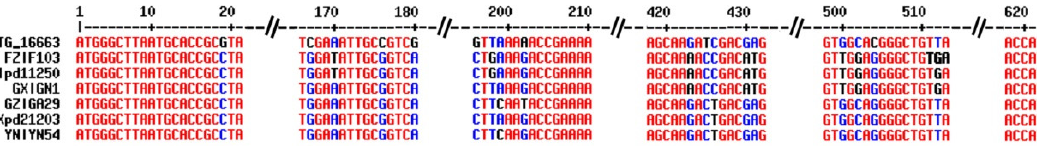
Figure 2. Representative nucleotide haplotypes showing point mutation and pre-termination sites of Avr1 gene. The name of isolates is presented in the left side of corresponding sequence.